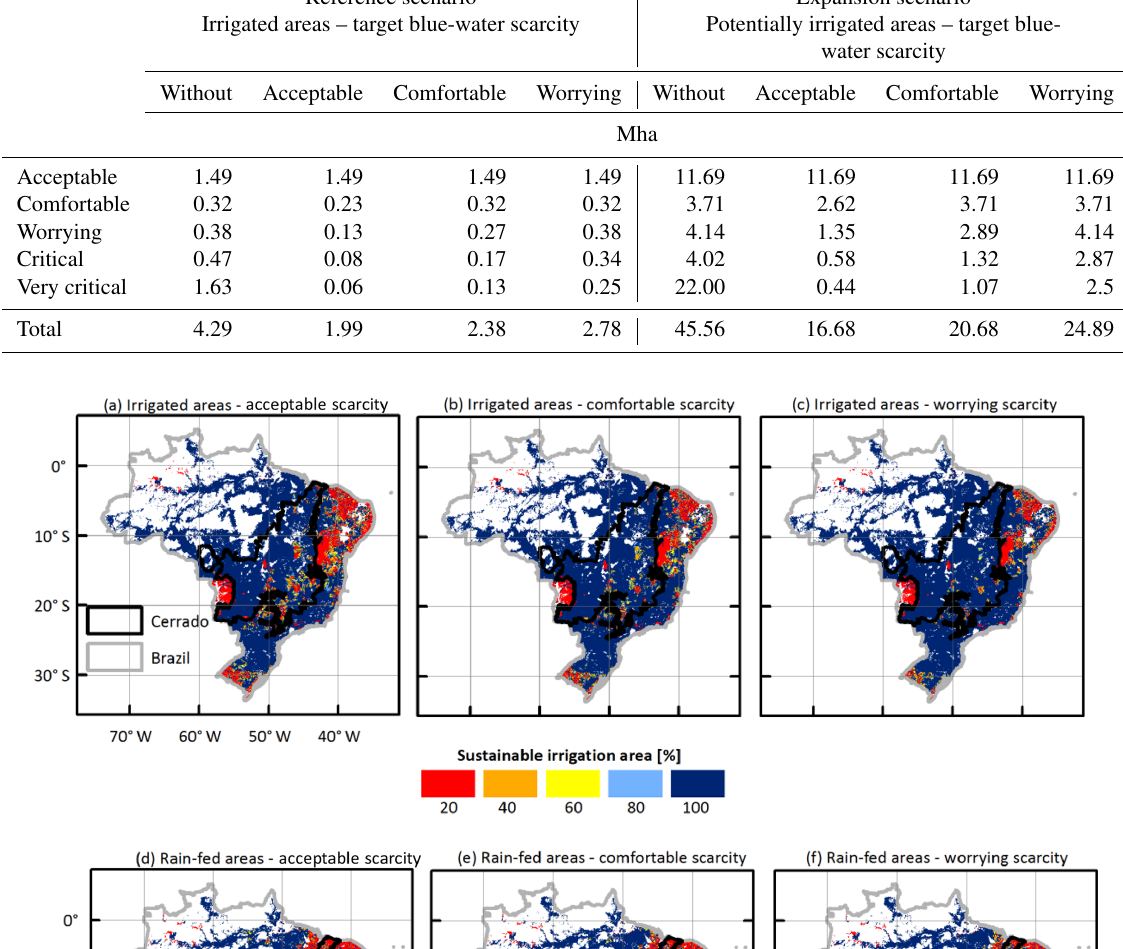
Q 95 complies with the indices utilised by the Brazilian water agency ANA and decision